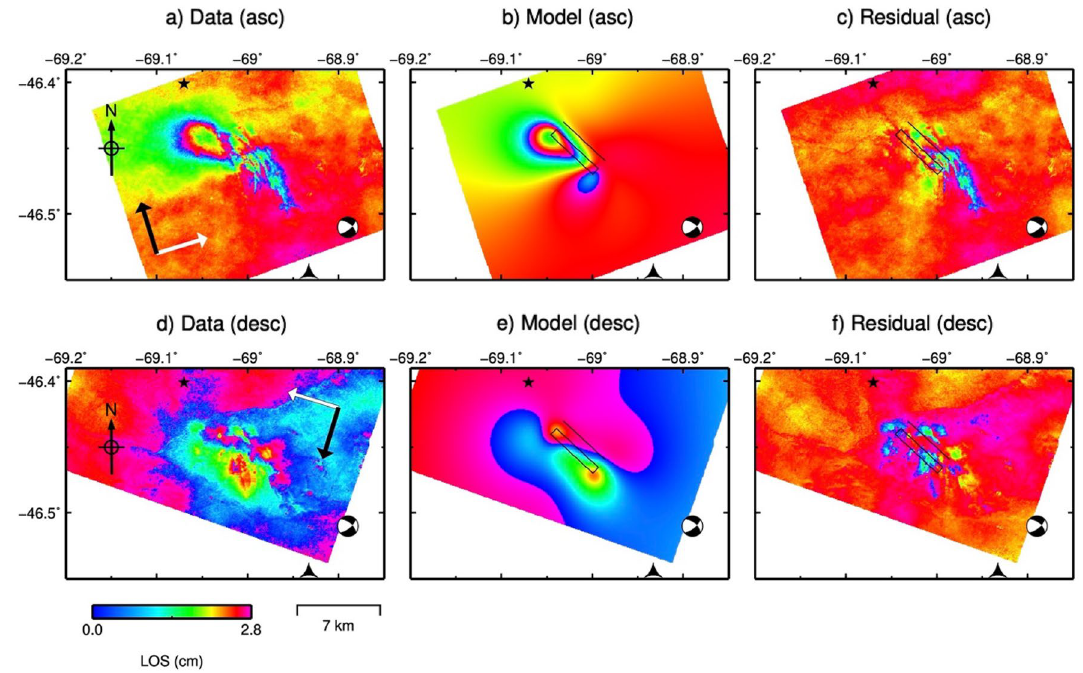
Figure 8. ( a ) and ( d ) Show co-seismic Line-Of-Sight (LOS) deformation of the Mw 4.9, 2019 October 17 GSJ basin earthquake obtained as the average of 4 and 6 co-seismic ascending and descending interferograms, respectively. The white arrows indicate satellite Line-of-Sight direction (LOS) and the black arrows indicates satellite azimuth (Az). ( b ) and ( e ) Show LOS deformation predicted by the forward model using the maximum a posteriori probability solution. ( c ) and ( f ) Show the residuals. The black rectangle represents the outline of the optimal fault plane, and the beach ball represents the fault plane solution from The Global Centroid Moment Tensor (GCMT, www. globa lcmt.